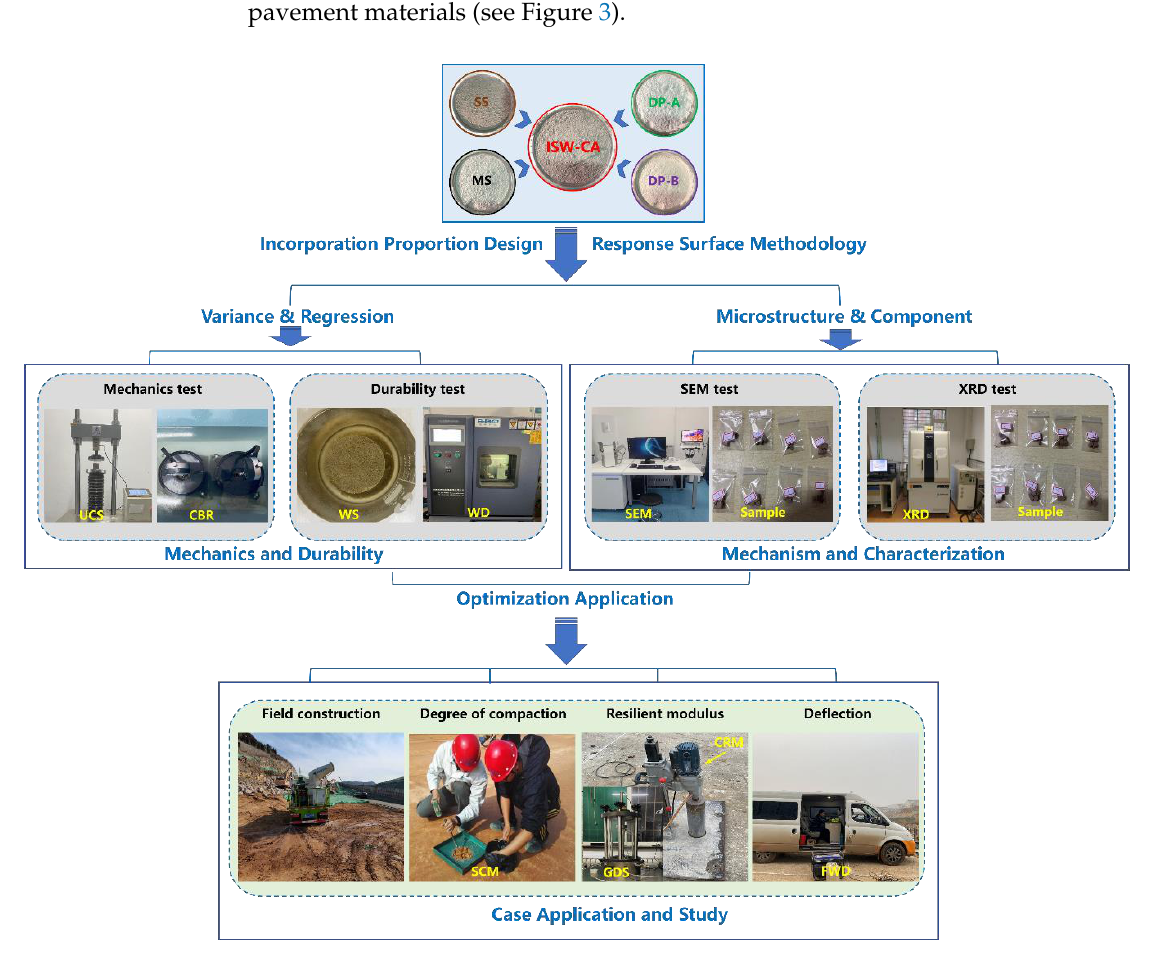
Figure 3. Evaluation study flowchart.